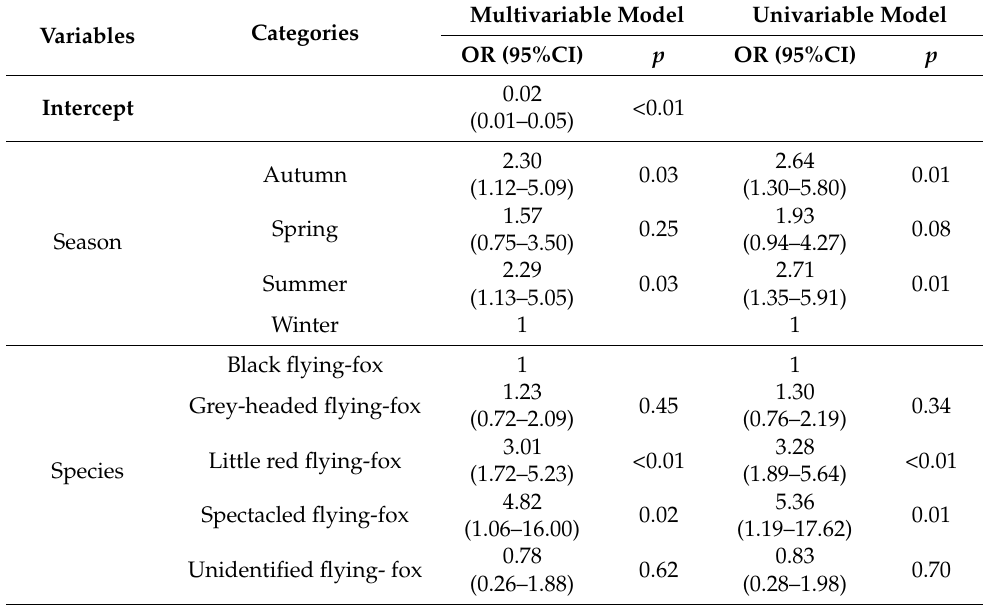
Table 3. Effects of season and species on infection